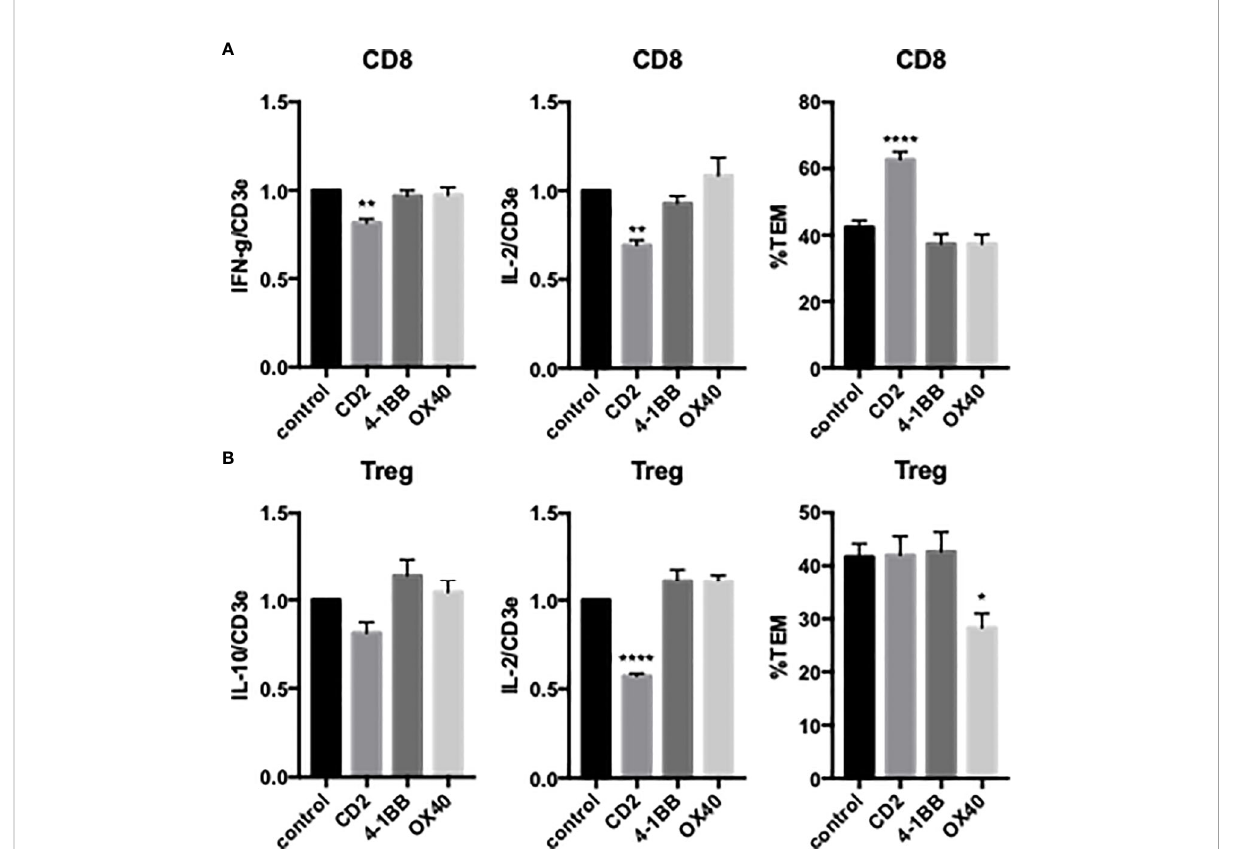
FIGURE 7 Effects of T cell CD2, 4-1BB and OX40 on cytokine expression and TCR-TEM of activated/expanded CD8 T EM and CD4 Treg. Activated/ expanded CD8 T EM (A) and CD4 Treg (B) were treated with blocking antibodies to CD2, 4-1BB, or OX40 and assayed for cytokine expression after 3 h (IFN- g and IL-2 for CD8, IL-10 and IL-2 for Treg, left and middle graphs) and TCR-TEM after 60 min fl ow (right graphs). *p<0.05; **p<0.01;